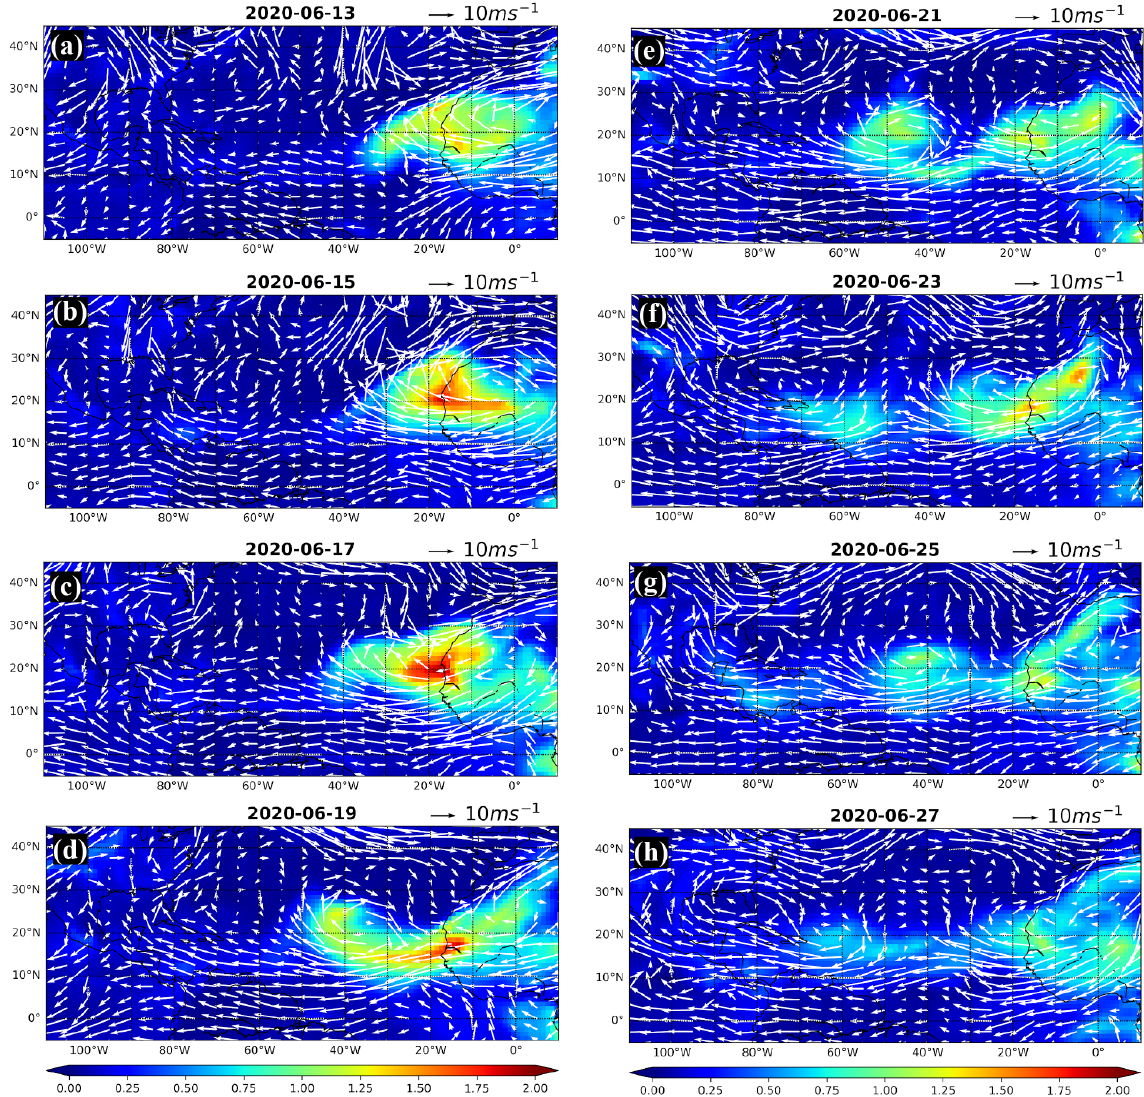
Figure 15. GEOS-simulated evolution of trans-Atlantic AOD (color map) during the period of 13–27 June 2020. Overlaid on the AOD map are MERRA-2 wind vectors at an altitude of about